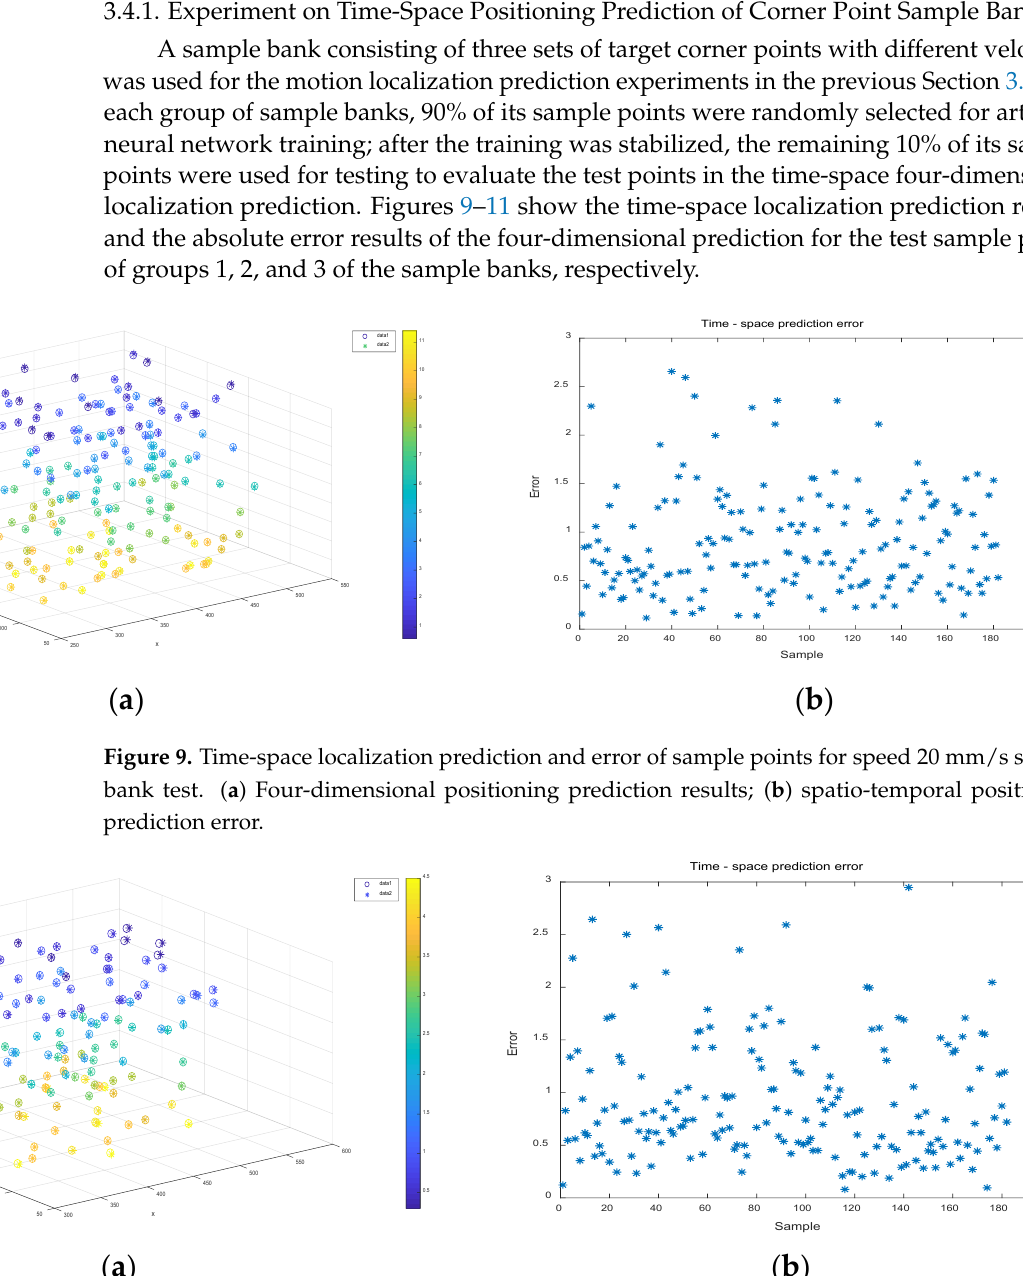
14 of 24 For each group of sample banks, 90% of its sample points were randomly selected for artificial neural network training; after the training was stabilized, the remaining 10% of its sample points were used for testing to evaluate the test points in the time-space four- dimensional localization prediction. Figures 9–11 show the time-space localization pre- diction results and the absolute error results of the four-dimensional prediction for the test sample points of groups 1, 2, and 3 of the sample banks, respectively. To visualize the time-space localization of the test sample points, a three-dimensional coordinate system combined with color is used to display the four-dimensional infor-